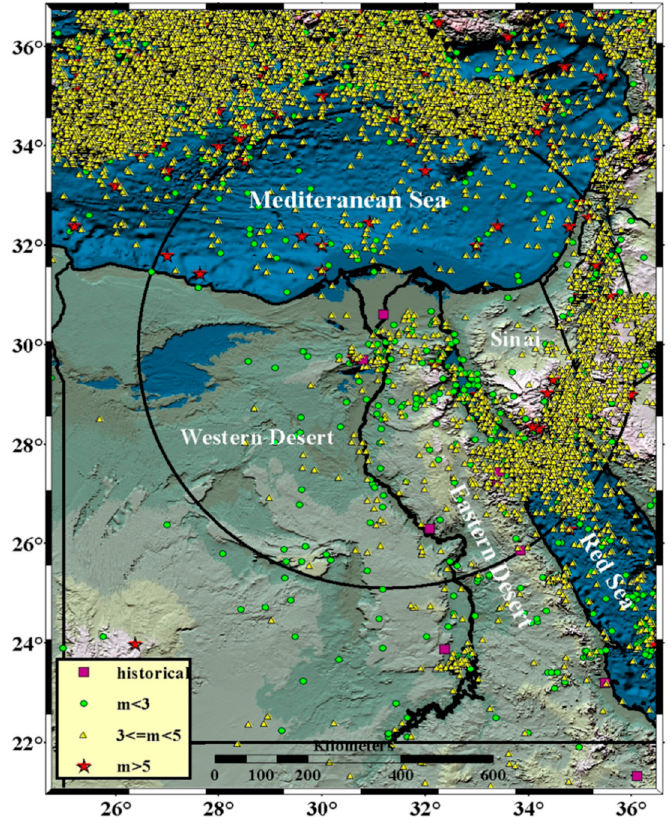
Figure 4. Seismicity of Eastern Mediterranean region based on the compiled earthquake catalog (Badawy et al. 2016) [43].